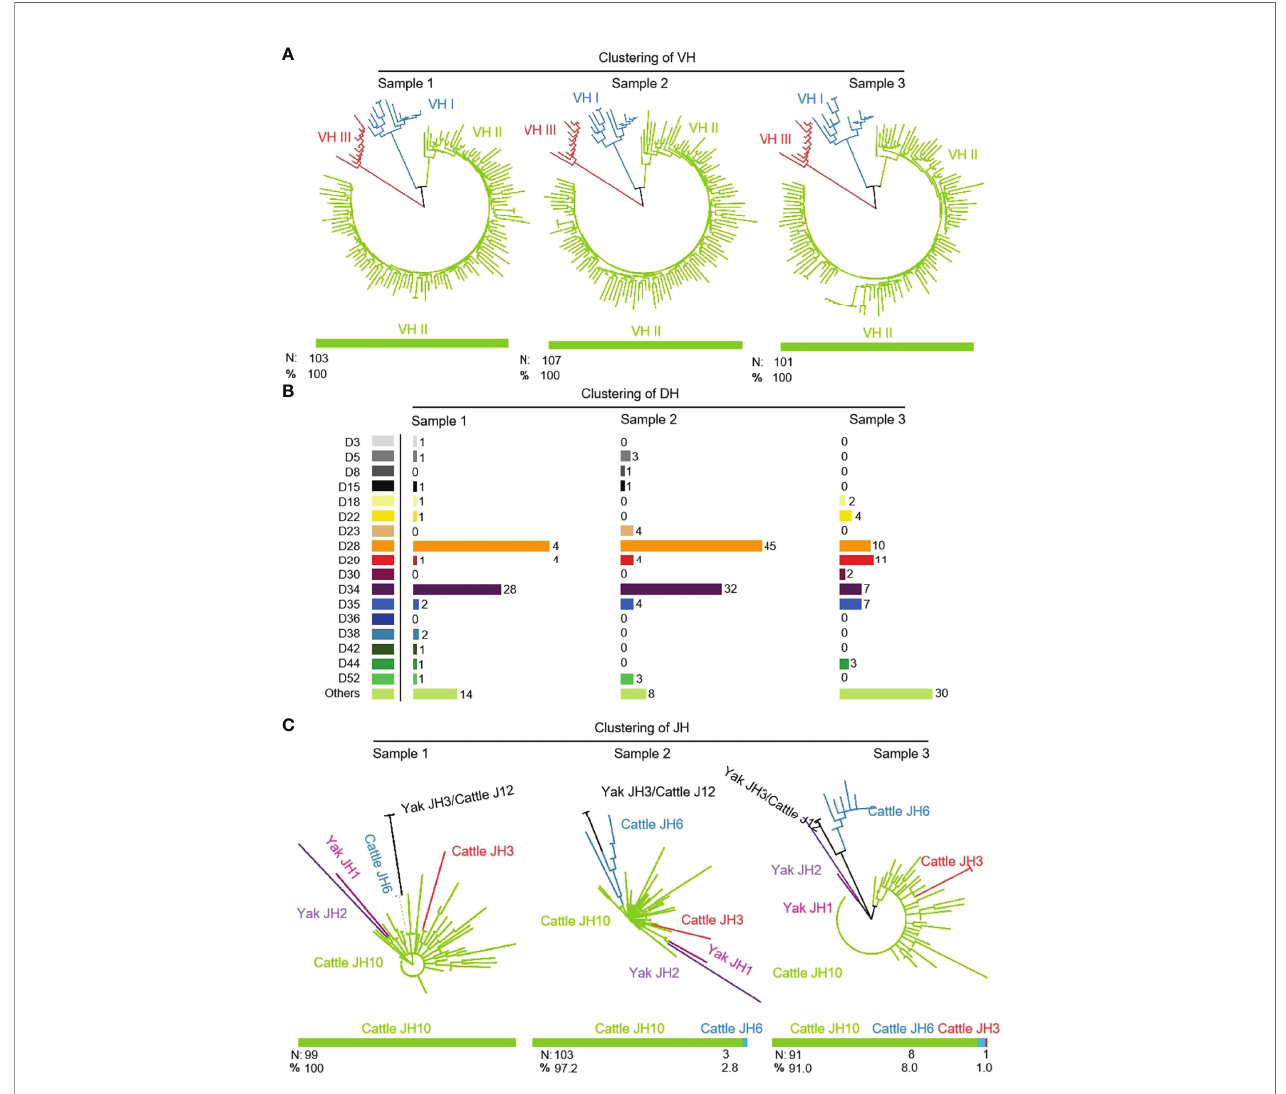
FIGURE 2 | The VH, DH and JH genes usage in Yak IgH. (A) Expression of the yak VH; (B) Expression of the yak DH; (C) Expression of the yak